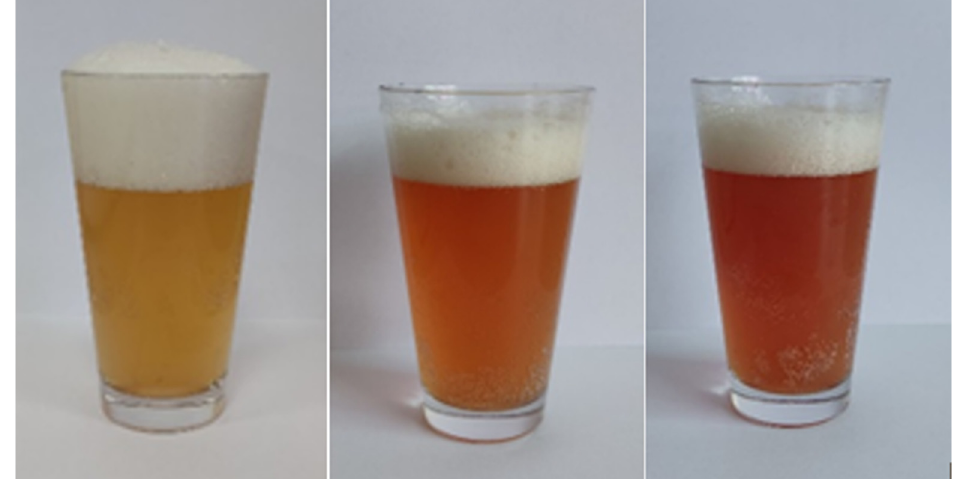
Figure 1. The appearance of the obtained wheat beers with addition of the Saskatoon berry fruits (from left to right)—CB—control beer, HB0—cv. ‘Honeywood’ with ozone-treated fruit and HB1— untreated fruit.